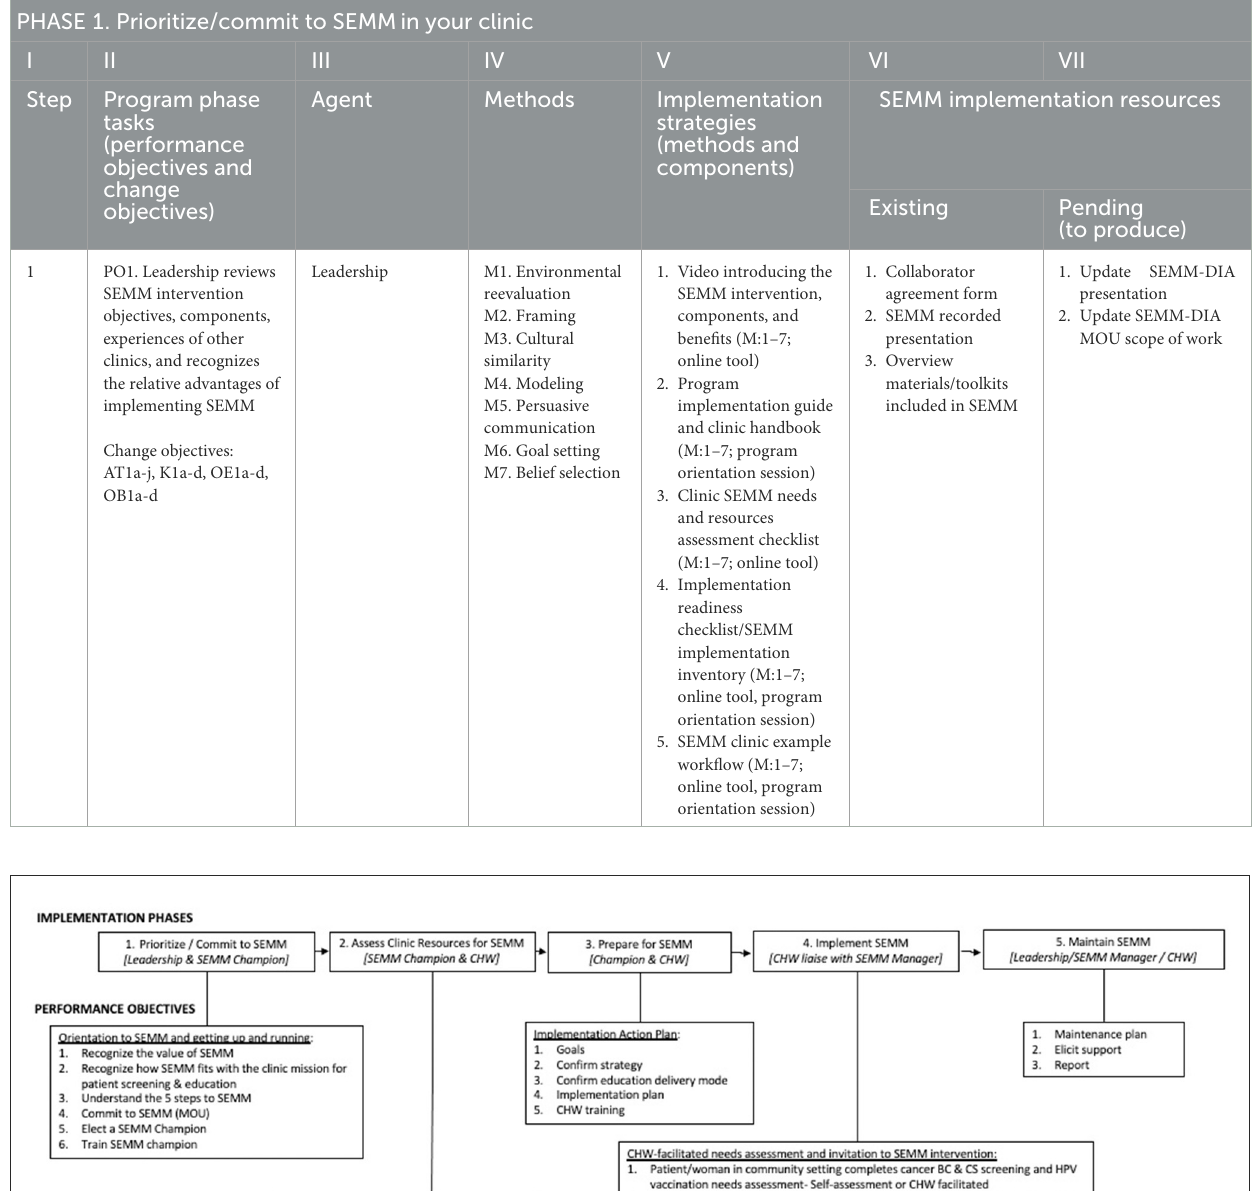
TABLE 6 SEMM-DIA resource inventory (example for phase 1, step 1). PHASE 1. Prioritize/commit to SEMM in your clinic